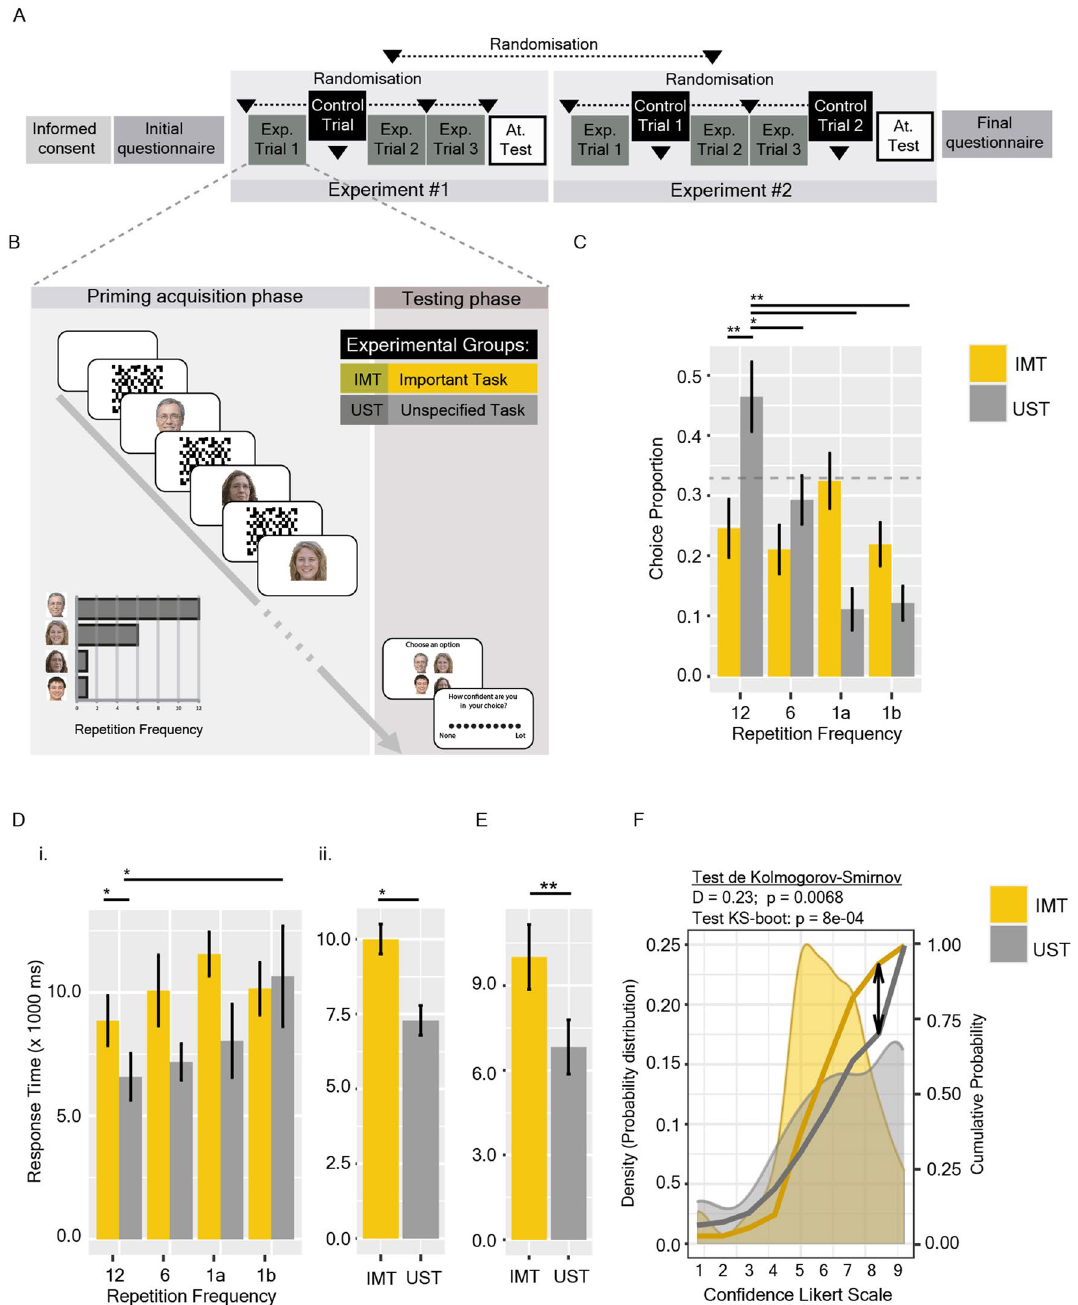
Figure 1. Repetition priming induces a choice preference associated with a lower response time in the Unspecified Task group but not in the Important Task group. ( A ) Experimental Series #1 design. The order in which the Experiment #1 and Experiment #2 appear, as well as the Control Trial position (Exp#1) and the Control Trial #1 or #2 (Exp#2), were all randomised for each participant. ( B ) Experimental design for Experiment #1: each experimental trial consists of two stages: a priming acquisition and a testing phase. The first one consists of faces (presented 12, 6 or 1 times; 200 ms face presentation) randomly presented, interspersed by a mask. The second one, in the election of only one face and the confidence of the choice. ( C ) Choice Preference as the proportion of the chosen face over a total of 3 trials. ( D ) Response Time separated by the chosen face frequency (i) or by group (ii). ( E ) Response Time, desegregated by group, of Control trials. ( F ) Probability Distribution of reported confidence. Areas show the density probability distribution; yellow and grey lines show the cumulative probability. Differences in the cumulative probabilities were analysed by the Kolmogorov– Smirnov (KS) Test: the arrow revealed the highest distance between distributions. Significances were also analysed by bootstrapping. Bars shown mean ± SEM. The grey dashed line represents the expected proportion for random choice (null hypothesis). *p < 0.05, **p <